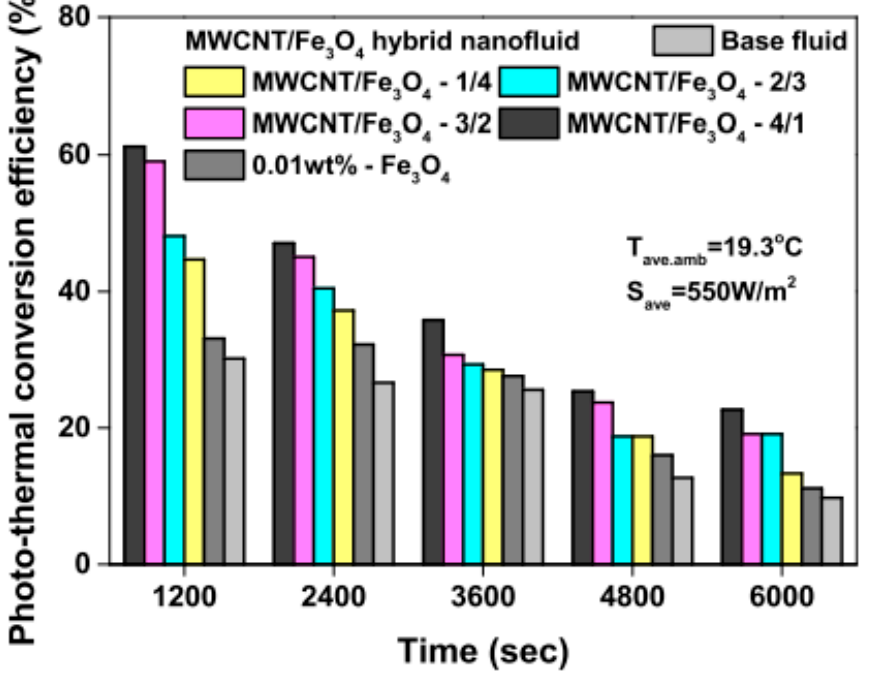
Figure 8. Photothermal energy conversion efficiency of MWCNT/Fe 3 O 4 nanofluids and base fluid with increasing irradiation (Adapted from Tong et al. [61]).